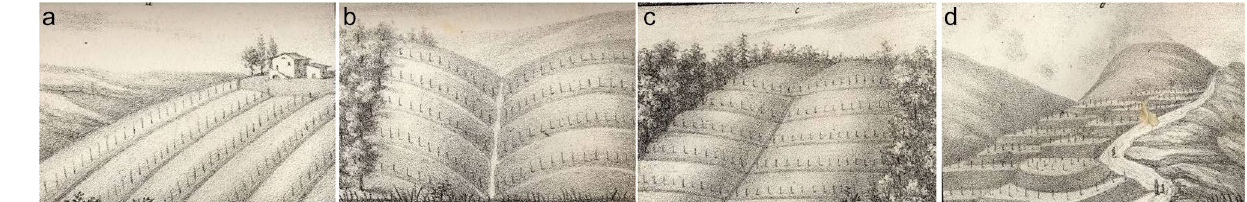
Figure 6. Tillage adopted in agriculture to contain soil erosion at the beginning of the nineteenth century in the Tiber River Basin: ( a ) slope with upright arrangement ( rittochino ) ( b ) hillock-cutter arrangement ( cavalcapoggio ) ( c ) riding on horseback ( tagliapoggio ) and ( d ) terracing arrangement ( ciglioni ) (arranged from ref. 70